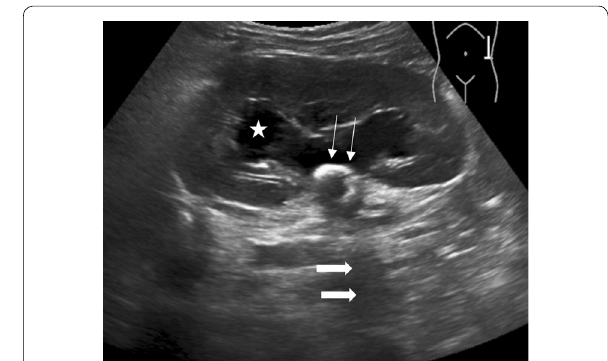
Fig. 4 Renal calculi: Renal calculi seen in the renal pelvis as an echogenic focus (long thin arrows). There is associated posterior acoustic shadowing seen behind the echogenic foci (thick arrows). Pelvicalyceal dilation is also seen secondary to obstructive